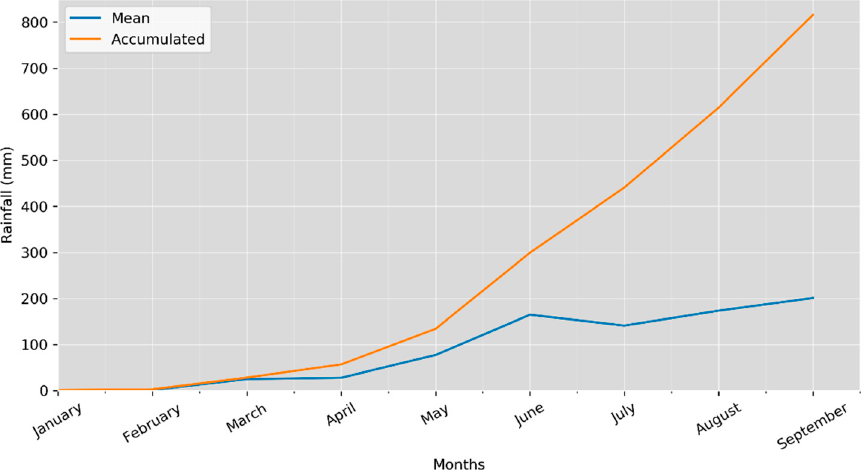
Figure 3. Mean and cumulative rainfall from January to September 2021